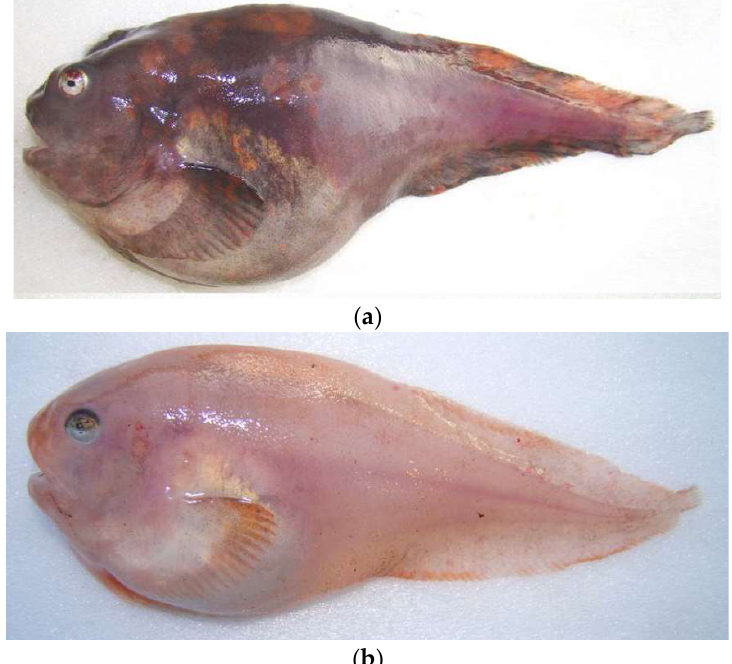
Figure 6. Arctic species of Careproctus : ( a ) C. fulvus. Holotype ZIN 55421, TL 224 mm; ( b ) C. rosa . Holotype, TL 121 mm.